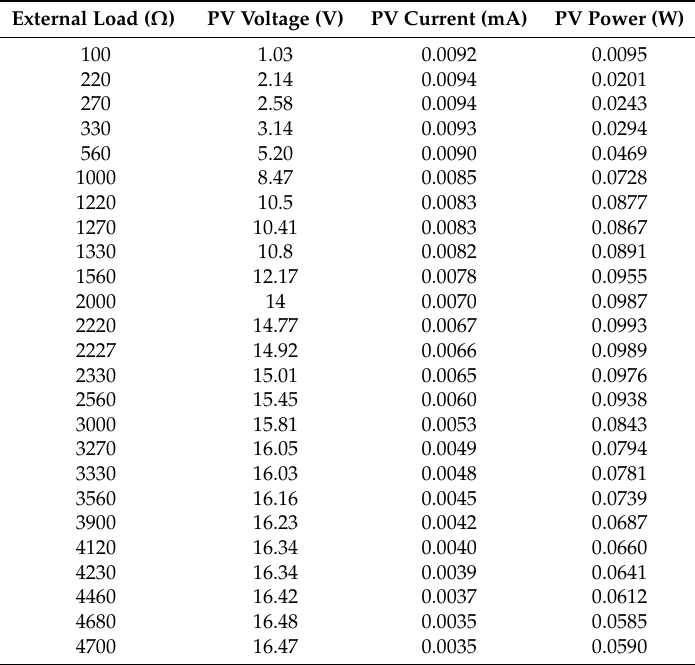
Table A1. Measured values for the high irradiation